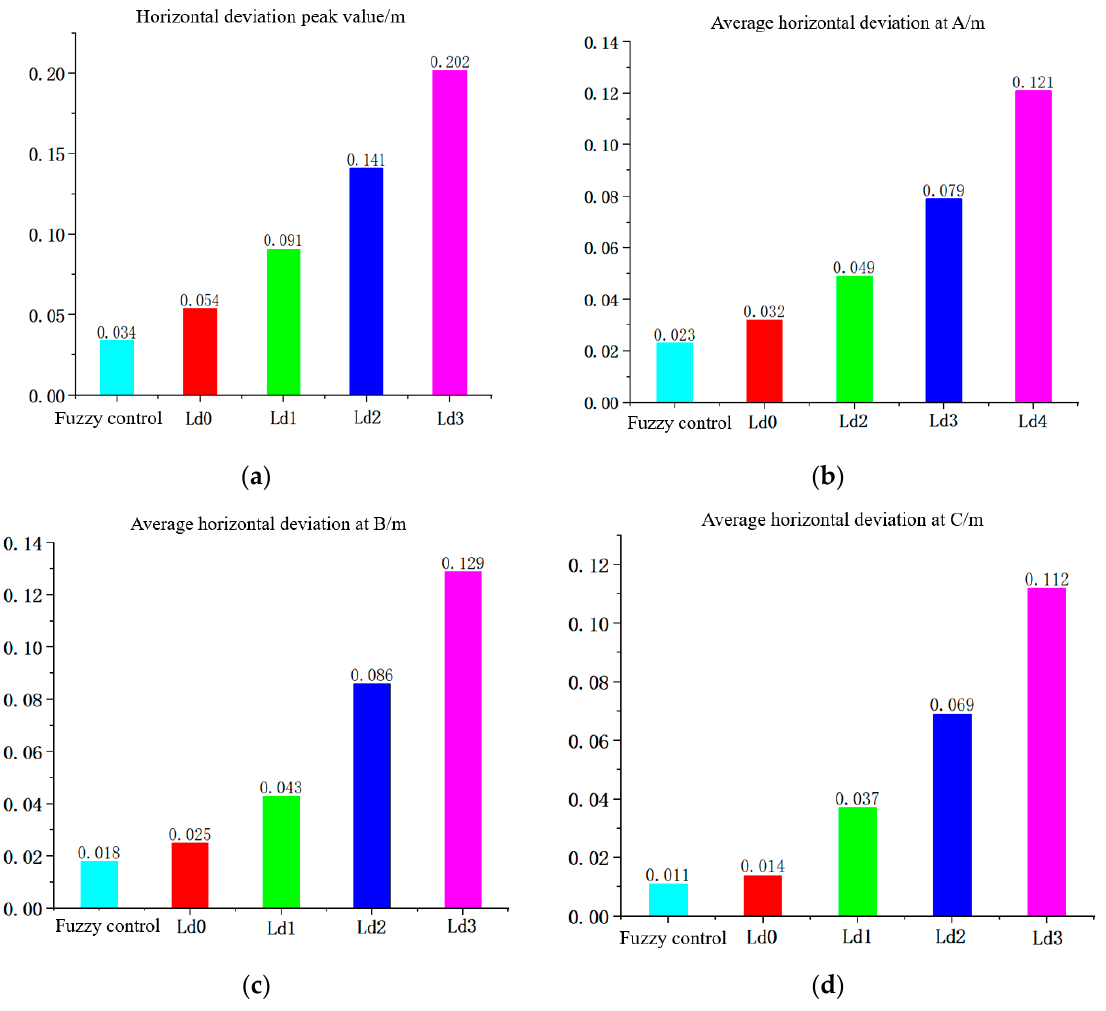
Figure 15. Comparison of lateral deviation of bow turn path. ( a ) Peak lateral deviation; ( b ) Average lateral deviation at A; ( c ) Average lateral deviation at B; ( d ) Average lateral deviation at C.